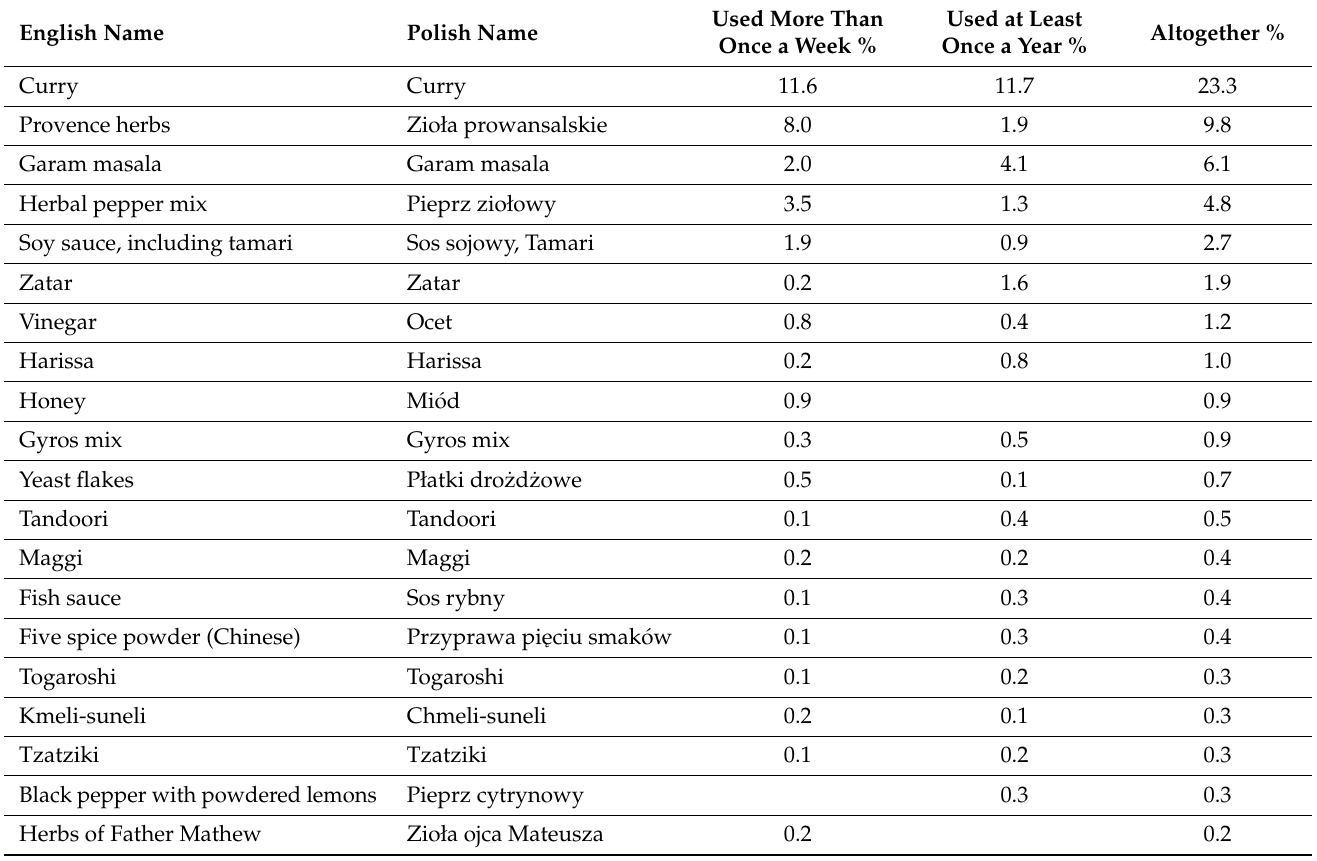
Table 2. Spice mixes and liquid non-botanical or mixed types of